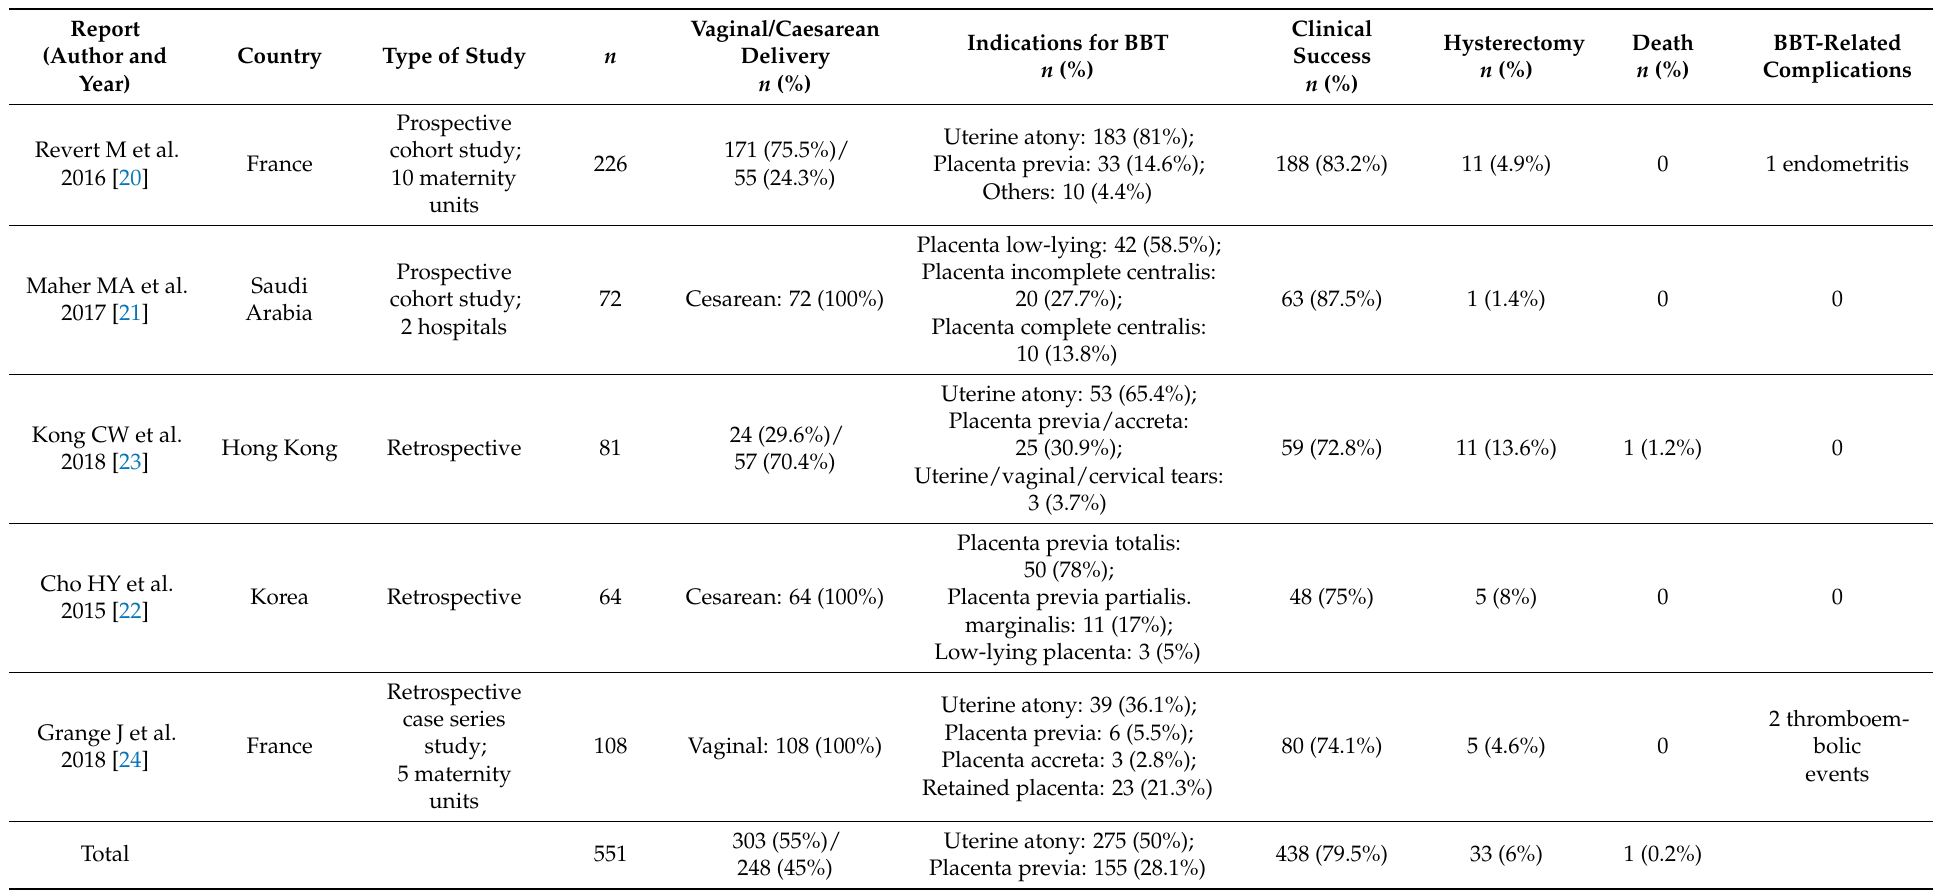
Table 3. Characteristics and clinical results of studies reported in the systematic